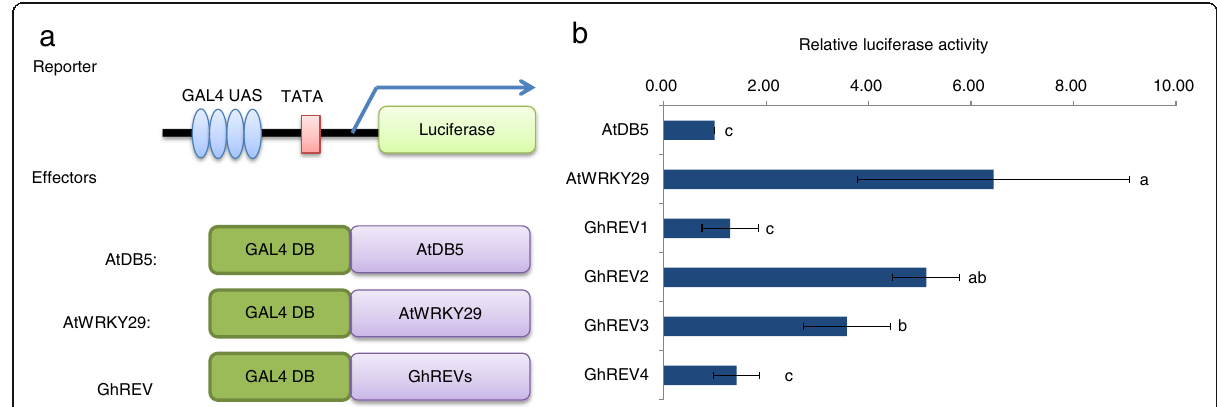
Fig. 3 Transcriptional activity of GhREVs. a Diagram of the reporter and effector constructs for the transactivation assay. The reporter includes four copies of GAL4 upstream activation sequence (UAS), a minimal 35S promoter (TATA box included), and a luciferase reporter gene. The effectors contain the GAL4 DNA-binding domain with AtDB5 (negative control) or with AtWRKY29 (positive control) or GhREVs under the control of the 35S promoter. b Relative luciferase activity of GhREVs in Arabidopsis protoplasts . Reporter and effector constructs were co-expressed in 10-day-old Arabidopsis protoplasts; and luciferase activity was measured 12 h after transfection. The data are shown as mean ± SD from three independent repeats ( n = 3). The above experiments were repeated three times with similar